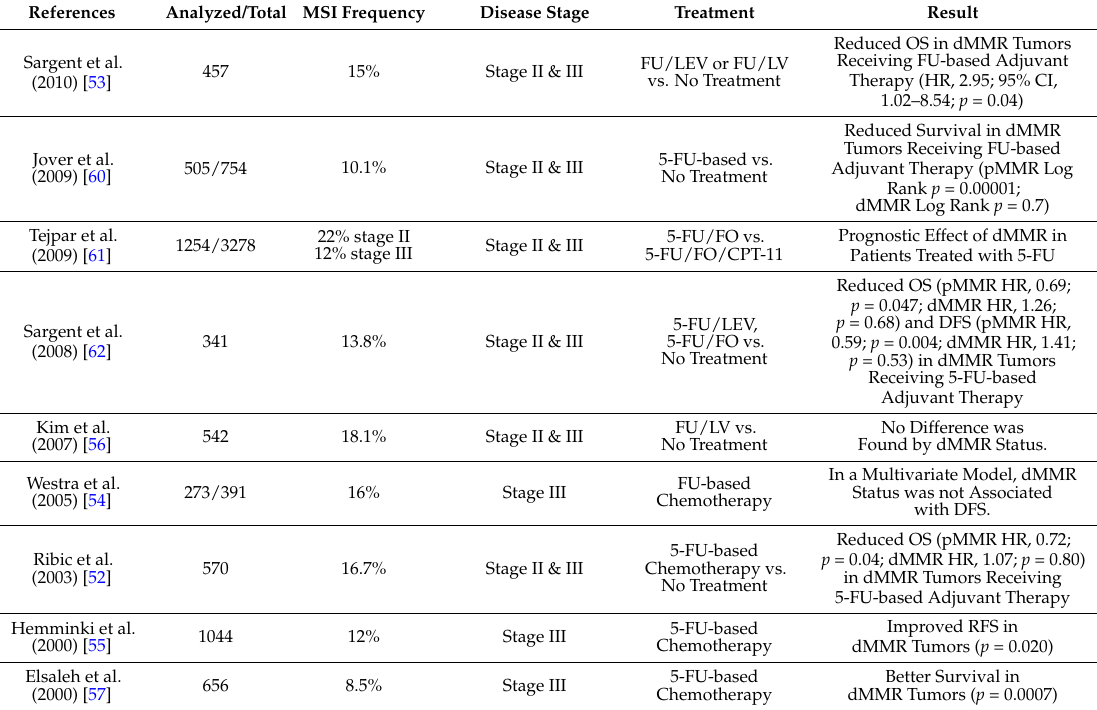
Table 1. Studies evaluating the impact of MMR status on the efficacy of 5-FU-based treatment in